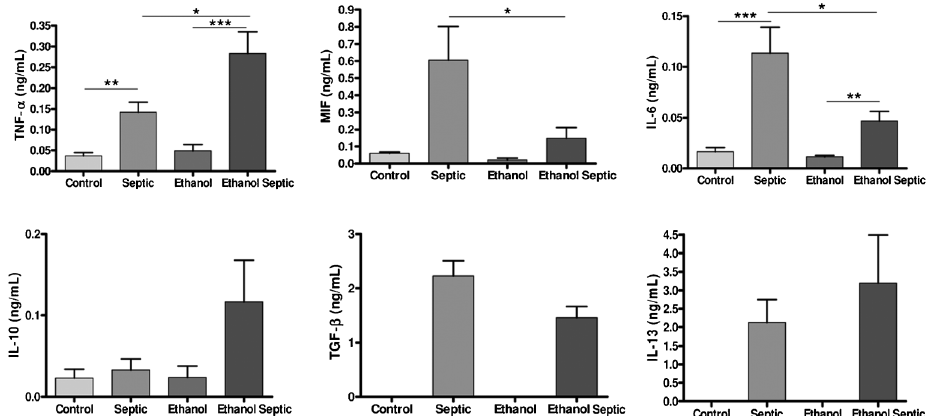
Figure 2. Ethanol consumption alters pro-inflammatory cytokine response after sepsis. Ethanol consumption did not interfere with anti- inflammatory cytokine response after sepsis. Control (n=12) and septic (n=20) groups received water, and ethanol (n=12) and ethanol septic (n=25) groups received 10% ethanol solution for 4 weeks. Septic and ethanol septic groups underwent septic procedure while control and ethanol groups received normal saline injected intraperitoneally. Whole blood was obtained by cardiac puncture 8 h after sepsis induction or saline injection in animals in estrus phase. Data are reported as means±SE from at least 12 animals. Tumor necrosis alpha (TNF- a ): *P=0.02; **P=0.004; ***P , 0.0001. Macrophage migration inhibitor factor (MIF): *P=0.03. Interleukin 6 (IL- 6): *P=0.04; **P=0.003; ***P=0.0005 (Mann-Whitney test). TNF- a : P , 0.0001; IL-6: P , 0.0001; MIF: P=0.041 (Kruskal-Wallis). No significant differences were found by Kruskal-Wallis (IL-10) and Mann-Whitney [transforming growth factor beta (TGF- b ); IL-13] tests.